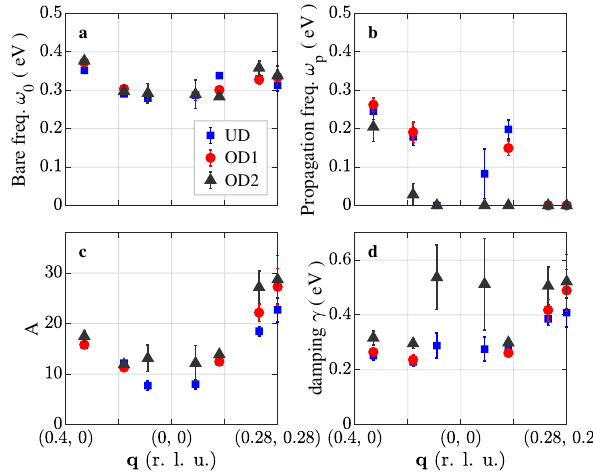
Fig. 4 Fitting parameters of the spin spectral functions in Fig. 3 by a damped harmonic oscillator model. a Bare frequency ω 0 . b Propagation frequency ω p . c Amplitude A . d Damping γ . The error bars represent the fi tting